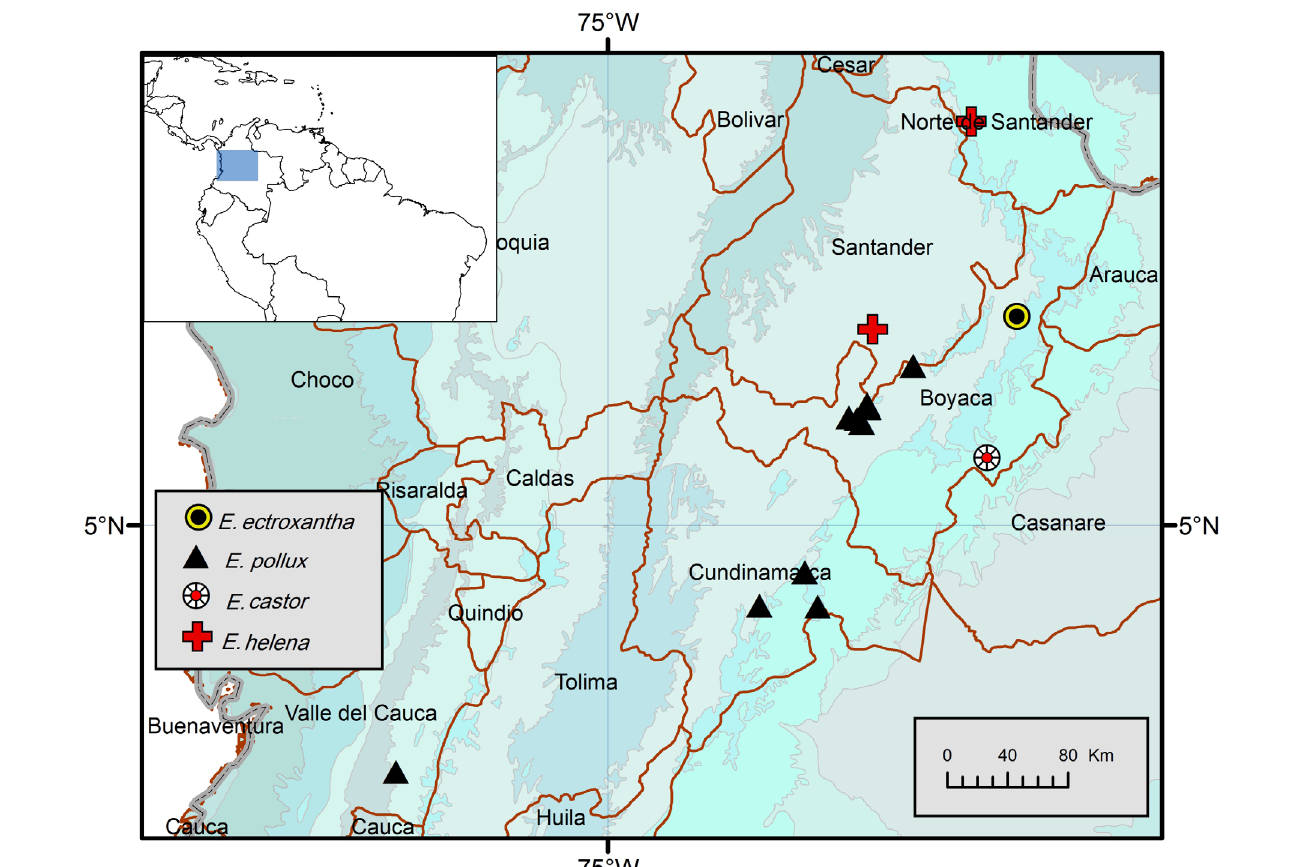
Fig. 34. Northern Andes in Colombia, showing localities for Eulibitia ectroxantha (Mello-Leitão, 1941) comb. nov., E. pollux sp. nov., E. castor sp. nov. and E. helena sp. nov. Colored patches on the background represent WWF